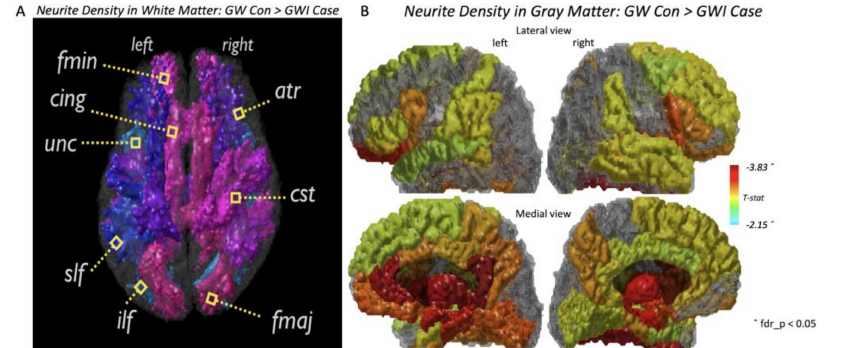
Figure 1. Gulf War illness (GWI) cases vs. Gulf War (GW) control group comparisons of gray matter (GM) and white matter (WM) neurite density imaging (NDI) measures and summary of significant regions. ( A ) 3D tract representation of significant WM ND di ff erences between GWI case and control groups. ( B ) 3D region of interest (ROI) representation of significant GM ND di ff erences between GWI case and control groups. Color bar corresponds to the magnitude of t-value, red indicates greater di ff erence between groups, and vice versa. Fmaj = corpus callosum forceps major, Fmin = corpus callosum forceps minor, atr = anterior thalamic radiations, cst = corticospinal tract, cing = cingulum cingulate gyrus bundle, ilf = inferior longitudinal fasciculus, slf = superior longitudinal